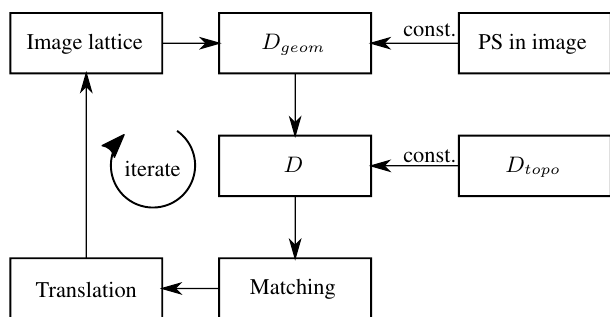
Figure 5: Flow chart of the iterative bipartite matching procedure. The PS in image coordinates as well as the topological informa- tion D topo are given and constant during all iterations. The dis- tance matrix D is composed of the geometrical and topological distance matrices. D is subject to a standard bipartite matching approach which leads to changed image coordinates of the lattice